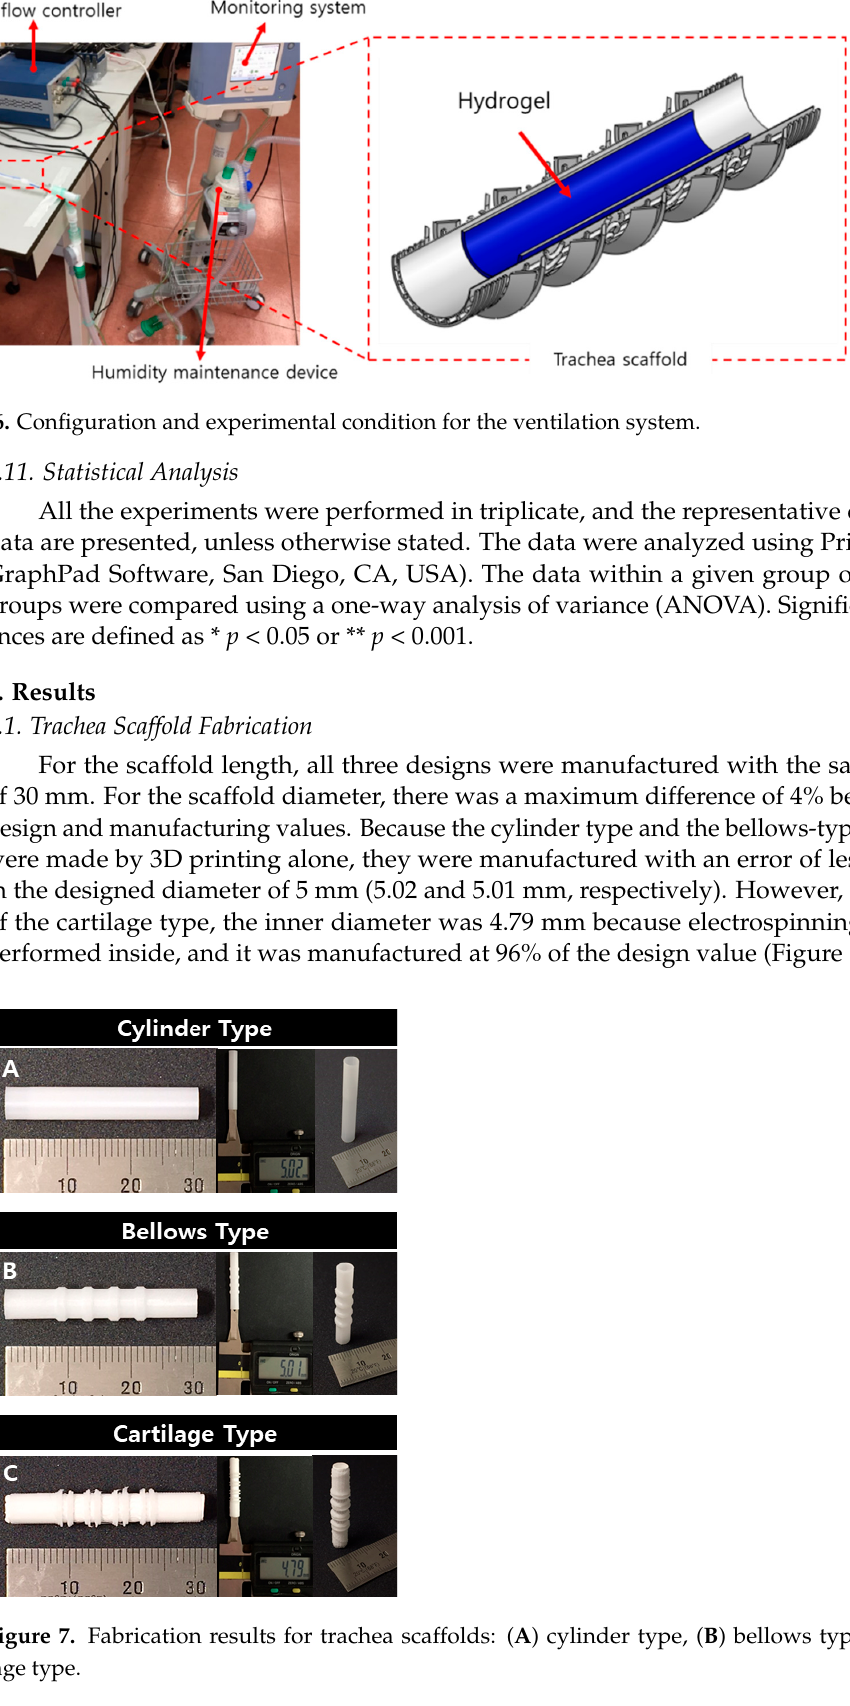
7 of 16 Figure 5. Experimental process using a circulation mock-up system. 2.10. Hydrogel Residual Inside of the Scaffold Assessed Using a Ventilation System To evaluate the effectiveness of the scaffold against internal tracheal stimuli such as breathing and coughing, hydrogel was printed inside the scaffolds, and the adhesion per-